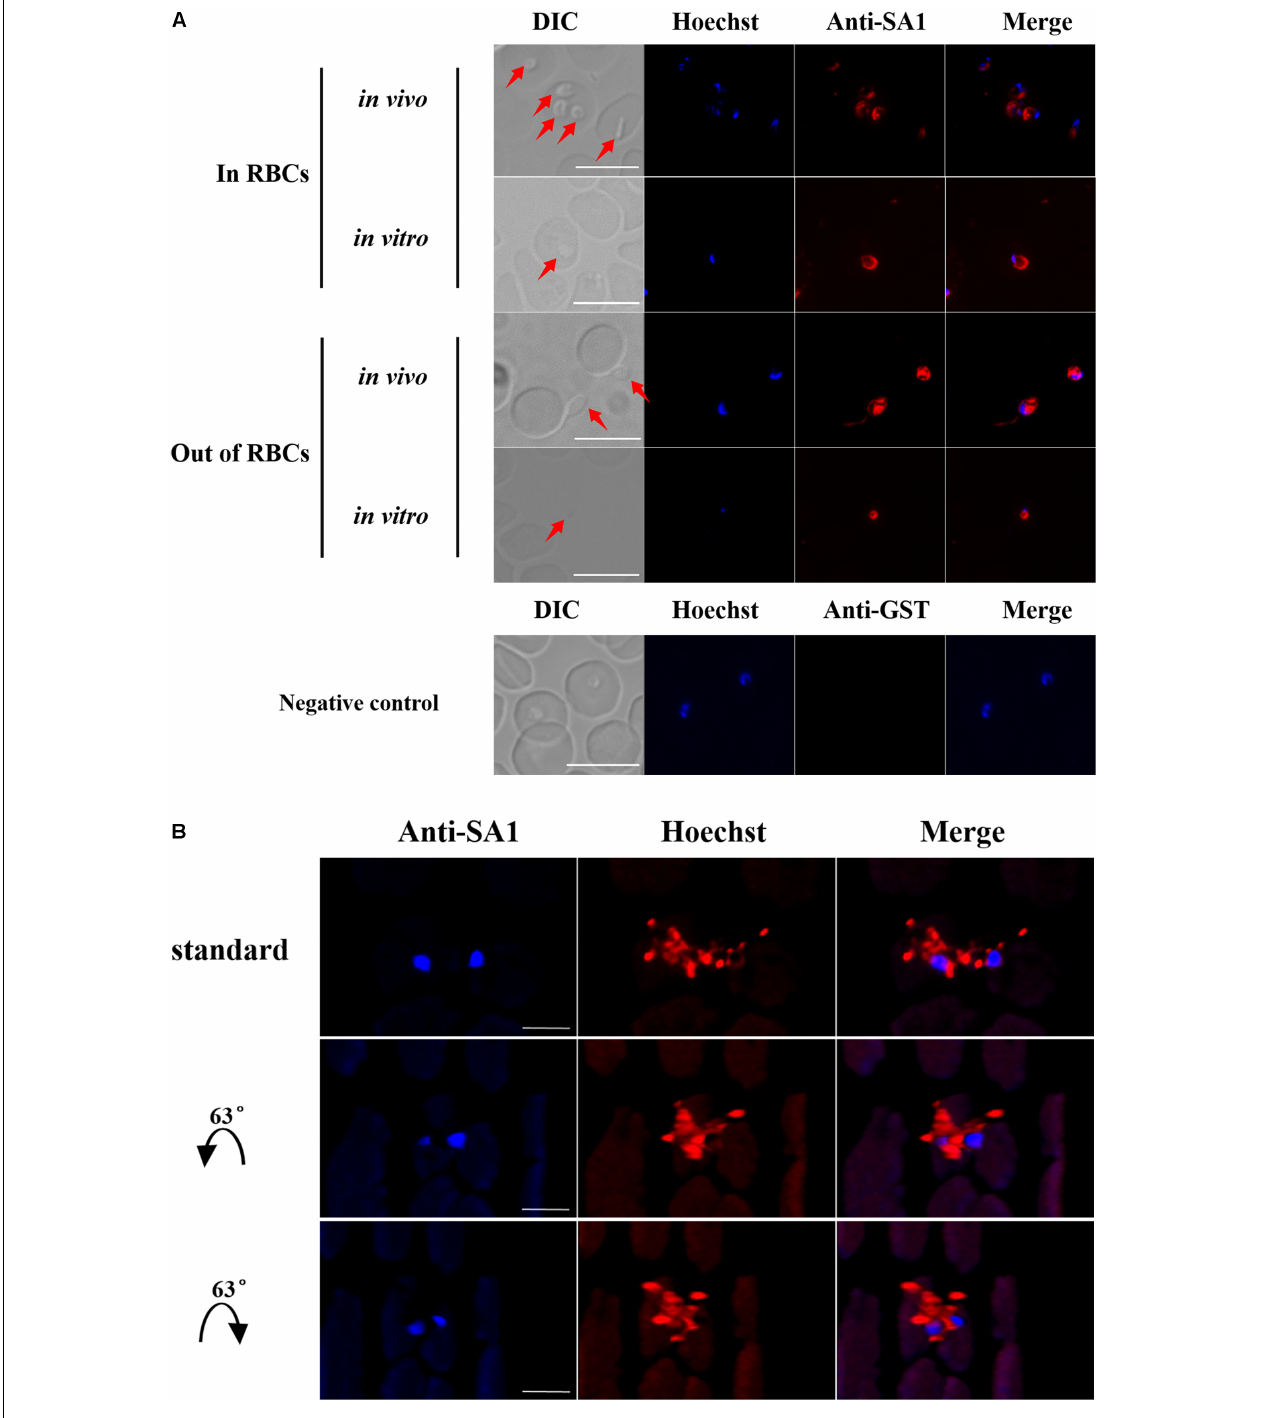
FIGURE 4 | Expression and localization of BmSA1 in B. microti . (A) IFA indicated that BmSA1 was expressed in different environments ( in vivo and in vitro ). BmSA1 was mainly localized in the membrane, with a small amount being distributed in the cytoplasm during the merozoite stage, and it was more expressed when parasites were outside RBCs. The parasite in DIC is indicated by red arrow. Scale bars = 5 µ m. (B) A three-dimensional perspective of the secretion of BmSA1 by parasites under a laser scanning confocal microscope.